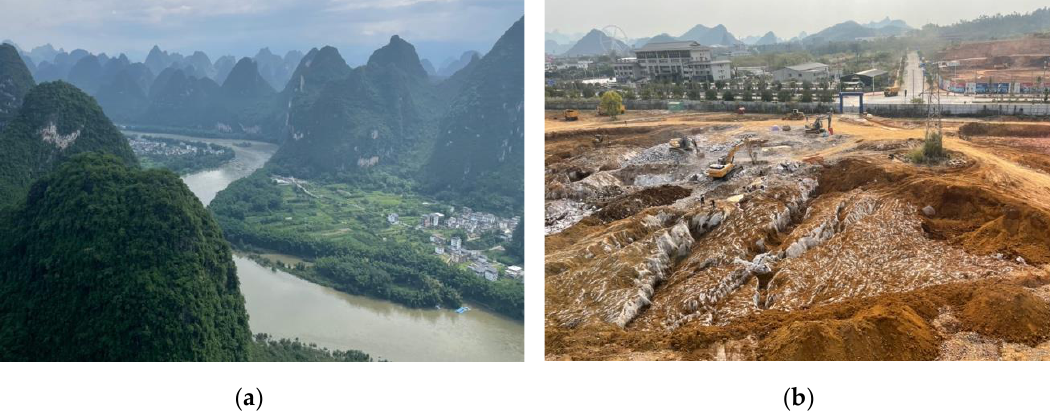
Figure 10. Conical shape karst around Yangshuo ( a ), a typical covered karst area in Lijiang River watershed ( b